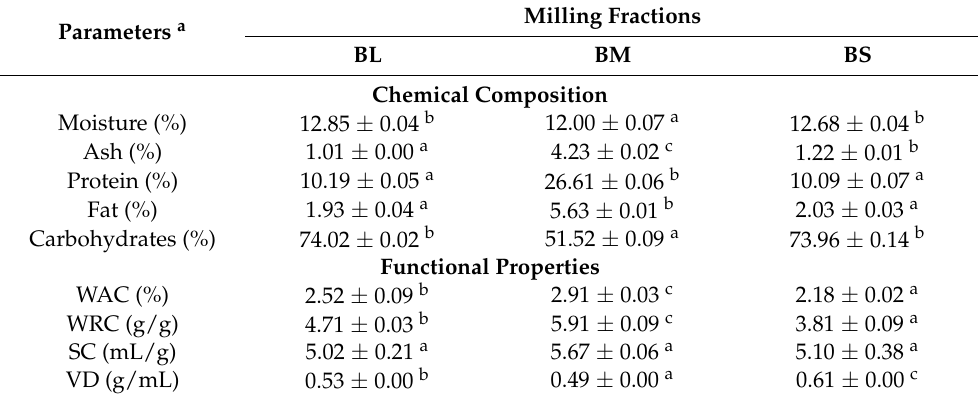
Table 2. Proximate composition and functional properties of buckwheat milling fractions. Milling Fractions Parameters a BL BM BS Chemical Composition Moisture (%)